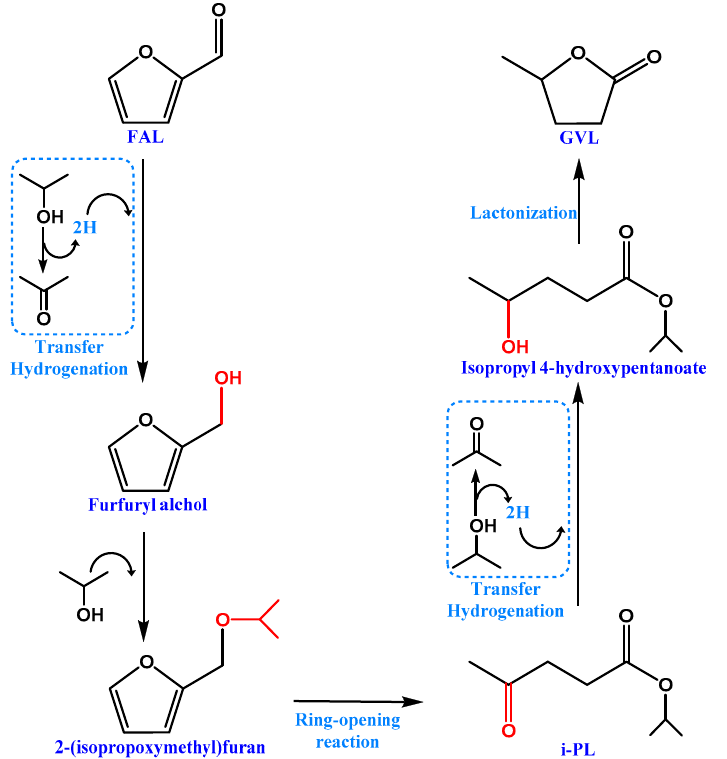
Scheme 4. Pathway for the furfural (FAL) to γ -valerolactone (GVL) overall transformation. In 5-hydroxymethylfurfural (HMF) heterogeneous oxidation to 2,5-diformylfuran